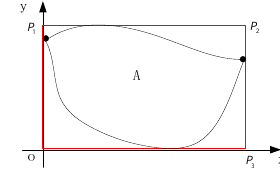
Figure 2. Schematic diagram of local Cartesian coordinates If the coordinate of the rectangular coordinate system ′ (x , y ) O W S origin is P (x , y ) E N top right corner point 2 is